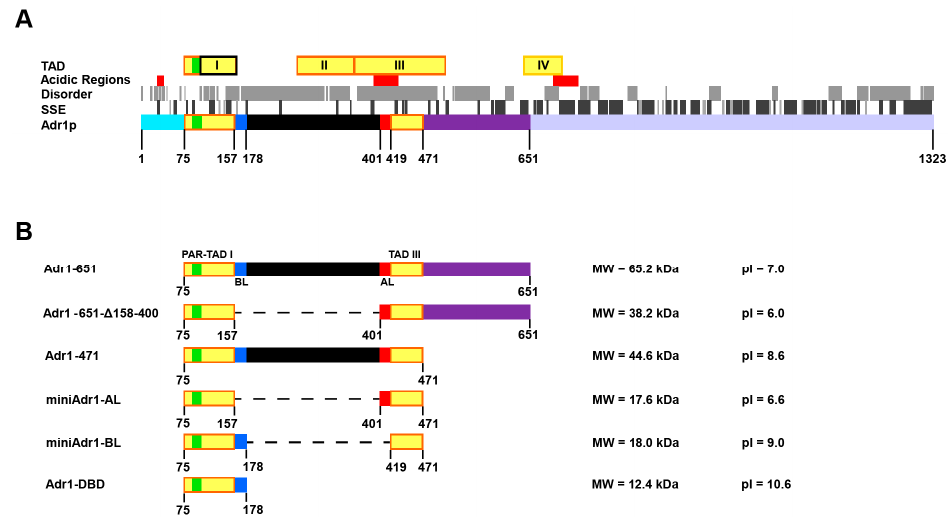
Figure 1. Adr1p and miniAdr1 constructs. ( A ) Schematic representation of full length Adr1p (UniProt ID: P07248, [27]). Acidic regions: residues belonging to the acidic regions, shown in red. Transcription Activation Domains (TAD) I, II, III, and IV are indicated by yellow boxes. The black square within TAD I indicates the largest Adr1p fragment, whose structure has been experimentally determined and is available from the PDB (PDB ID: 2ADR; [23]); the green box is the PAR region within TAD I. Segments of the protein between TAD I and TAD III are in black to highlight their deletion; residues of the basic linker and acid linker are in blue and red, respectively. Disorder: sequence regions predicted to be disordered by the PsiPred server [28], shown in light grey. SSE: Secondary structure elements, α -helices and β -strands, shown in dark grey and light grey, respectively. SSE in regions whose 3D structure has been experimentally determined were assigned by the PDBSum server [29], while in all other regions they were predicted by I-TASSER [30]. Adr1p: protein regions present in miniAdr1 constructs, indicated by di ff erent colors, with the number of starting and / or ending residues. ( B ) Schematic representation of miniAdr1 constructs following the color codes used previously (A). For each construct, the molecular weight (MW, kDa) and theoretical isoelectric points (pI), calculated by ProtParam [31], are